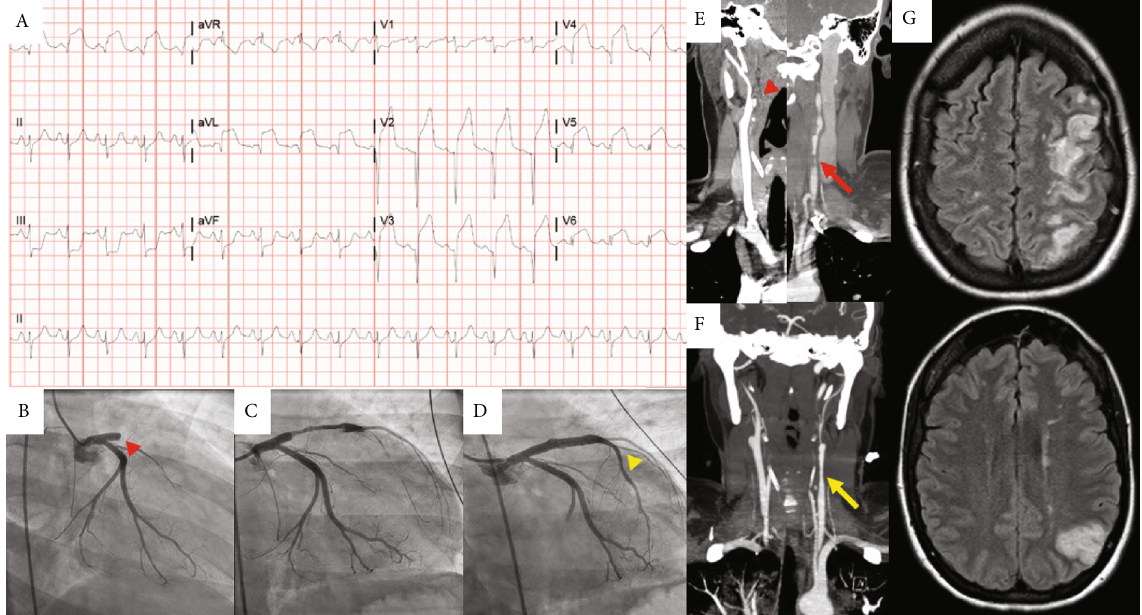
Figure 1: Cardiovascular and neurovascular imaging. Electrocardiogram (A) demonstrating anterolateral STEMI. Coronary angiography demonstrated complete occlusion of the LAD (B; red arrowhead) with partial reconstitution of fl ow following wiring (C) and restoration of normal fl ow following stent deployment (D; yellow arrowhead). CT angiography (E) demonstrated complete occlusion of the right ICA (red arrowhead) with luminal narrowing and irregularity of the left ICA consistent with dissection and associated thrombus (red arrow). Subsequent CT angiography showed improvement of the left ICA (F, yellow arrow). MRI demonstrated left frontal and parietal lobar multifocal infarction